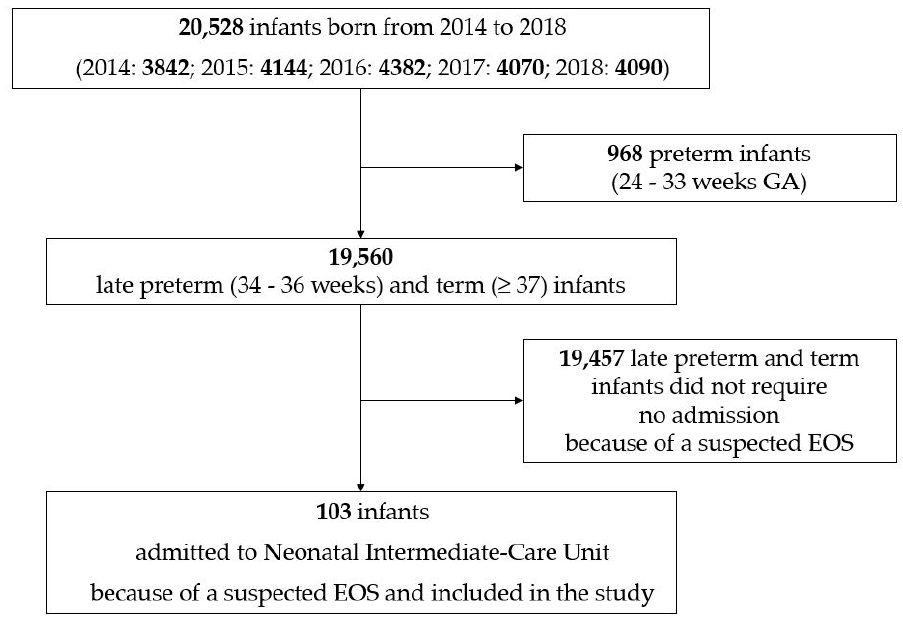
Figure 1. Flowchart of the design of the study.